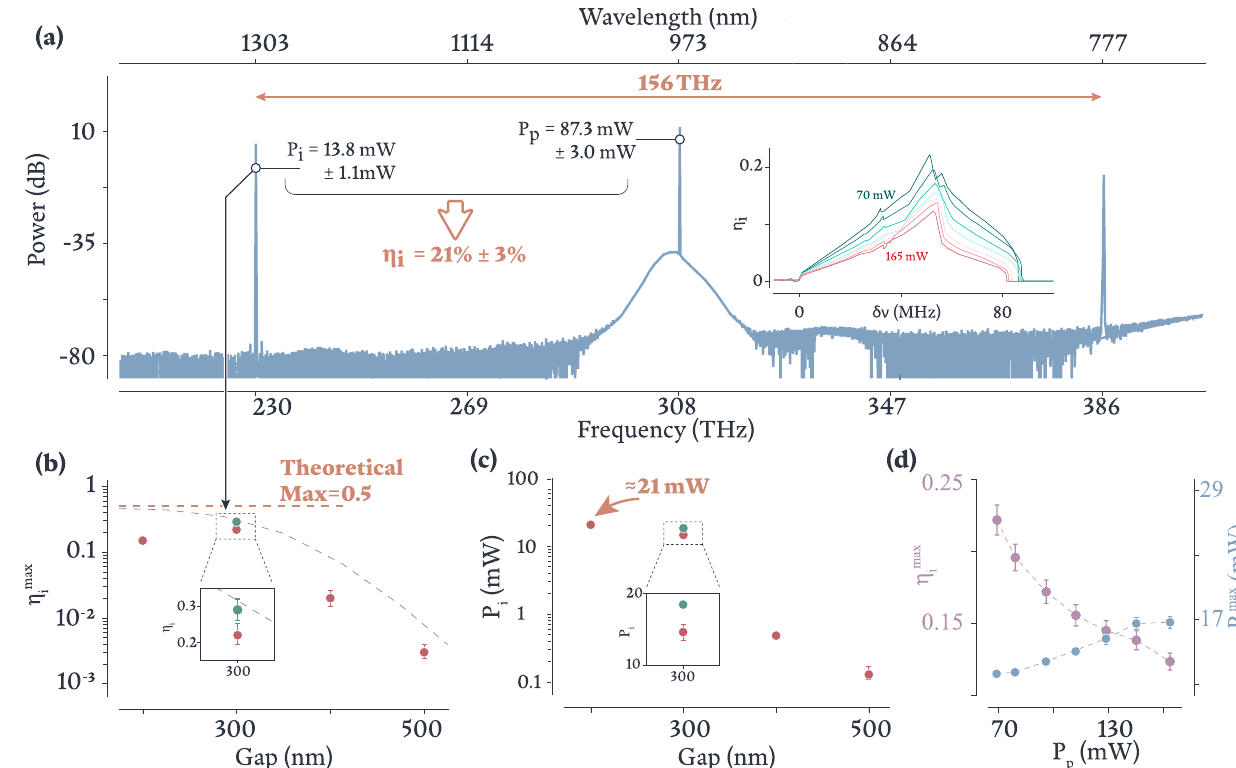
Fig. 3 | High-performance OPO. a Representative spectrum from an OPO device producing (13.8±1.1)mW of on-chip idler power for an on-chip pump power of (87.3±3.0)mW,correspondingtoaconversionef fi ciencyof(0.21±0.03)(interms of photon fl ux). A power of 0 dB is referenced to 1mW (i.e., dBm); the offset between the plotted dB values and the on-chip power values P p and P i are due to fi ber coupling and other insertion losses (see Supplementary Material for details). Theinsetdisplays η i and P i fordifferentpumppower(increasingfromgreentored) andpumpfrequencydetuning. b , c Peakconversionef fi ciency η max i ( b )andon-chip idler power P i ( c ) as a function of resonator-waveguide gap for a series of OPO devices. η max and P i monotonically increase with decreasing gap (increased cou- pling)untilagapof200nm,atwhichpoint η max i isreduced,asdiscussedinthetext. Thedashedgraylinein b showsthetheoreticalvaluefor η max i basedonthecoupling